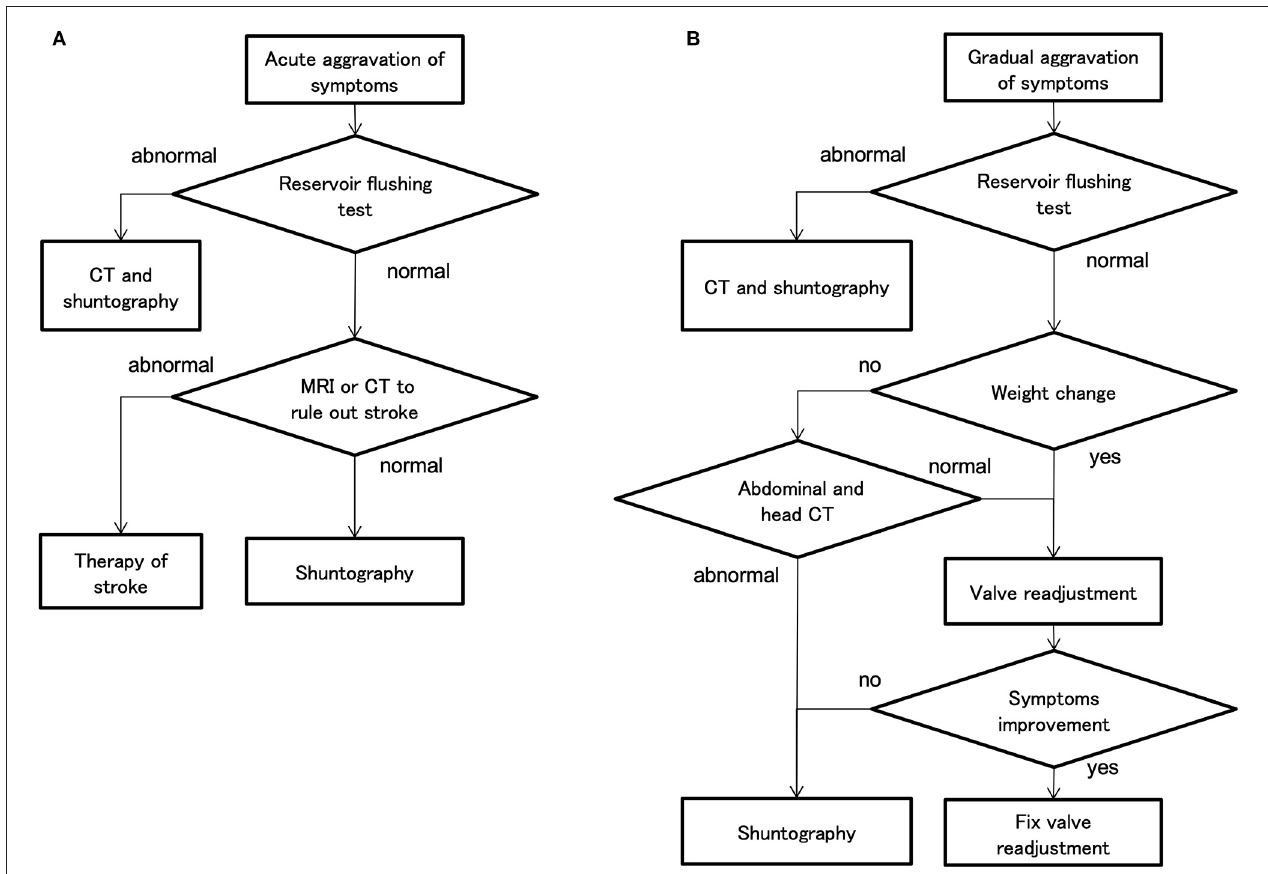
FIGURE 8 | The decision flow chart at symptom aggravation. (A) In cases of acute aggravation, the first step is to perform a reservoir flushing test, which can be easily performed in the examination room. If the reservoir flushing test is normal, the physician should differentiate a stroke by magnetic resonance imaging (MRI). (B) In cases of gradual aggravation in about 3 months, first perform a reservoir flushing test. If the reservoir flushing test is normal and the weight has changed by several kilograms, the physician should readjust the valve. In the case of weight gain, lower the setting by 30–60mm H 2 O for the CH valve and by one level for the CERTAS plus and STRATA NSC valves. If there is no improvement after 1 month of valve readjustment, the physician should consider performing